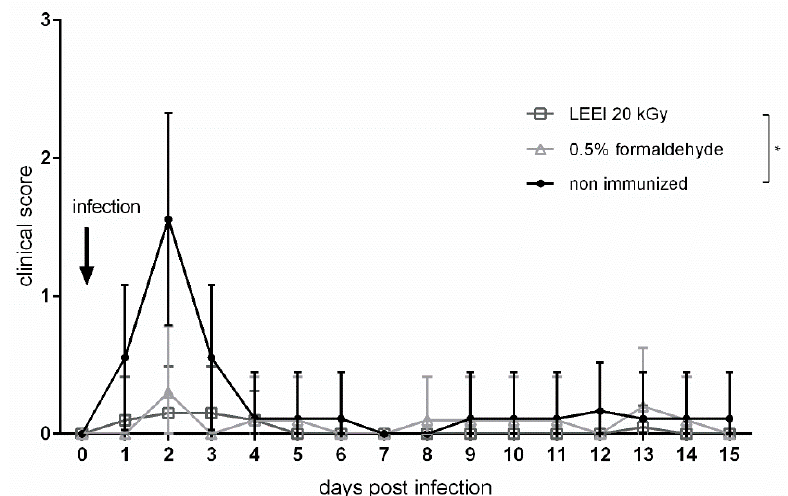
Figure 3. Clinical scores after challenge of vaccinated and non-vaccinated mice . Clinical score of mice after intranasal challenge with a sub-lethal dose of R. pneumotropicus strain JF4Ni. Empty grey rectangles indicate LEEI-inactivated material. Empty grey triangles indicate formaldehyde-inactivated material. Black dots indicate non-vaccinated animals (control). A score of 1 was applied to animals losing 5% to 19% of body weight. p -value was determined by two-way ANOVA. * indicates p ≤ 0.05.